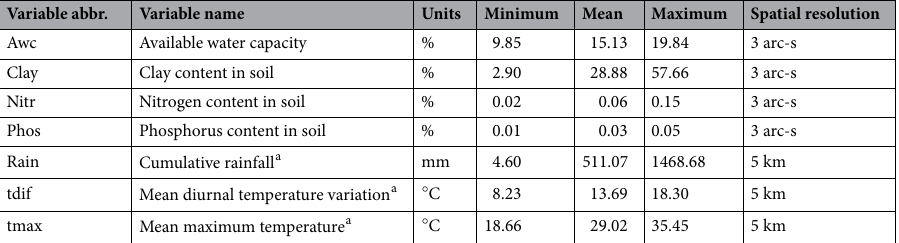
Table 2. Summary statistics of the climatic and edaphic variables used in the study. species presence/absence